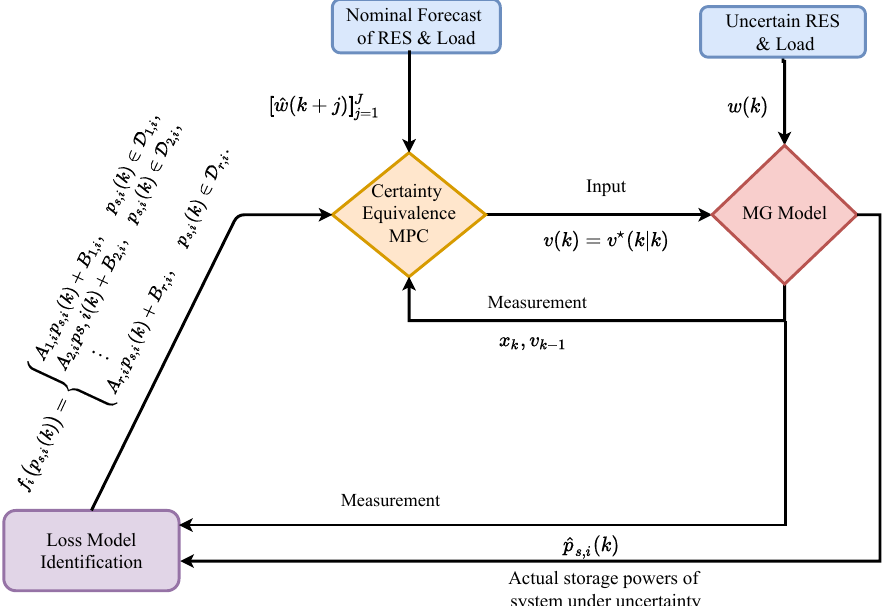
Figure 3. Control scheme of certainty equivalence MPC under the conversion loss